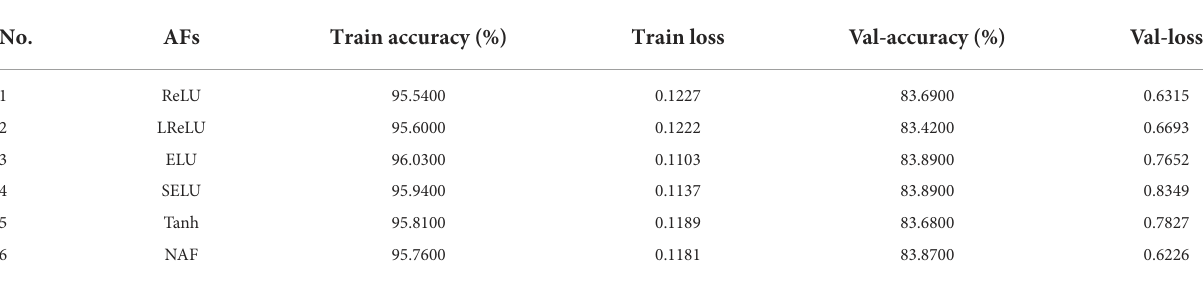
TABLE 4 LSTM model with different AFs for IMDB sentiment